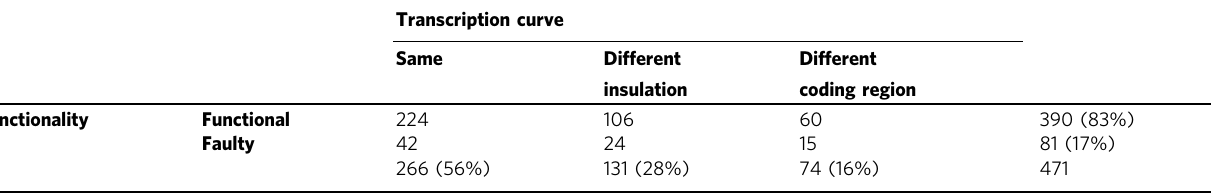
Table 1 Comparison of the complementary measures functionality as derived through Tncite and transcription curve as derived through RNA-Seq as methods to pinpoint errors in genome